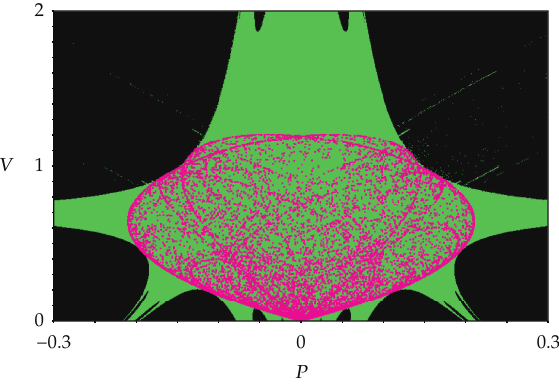
Figure 5: Boundary crisis (cid:3) N (cid:8) 3 . 378 (cid:4)